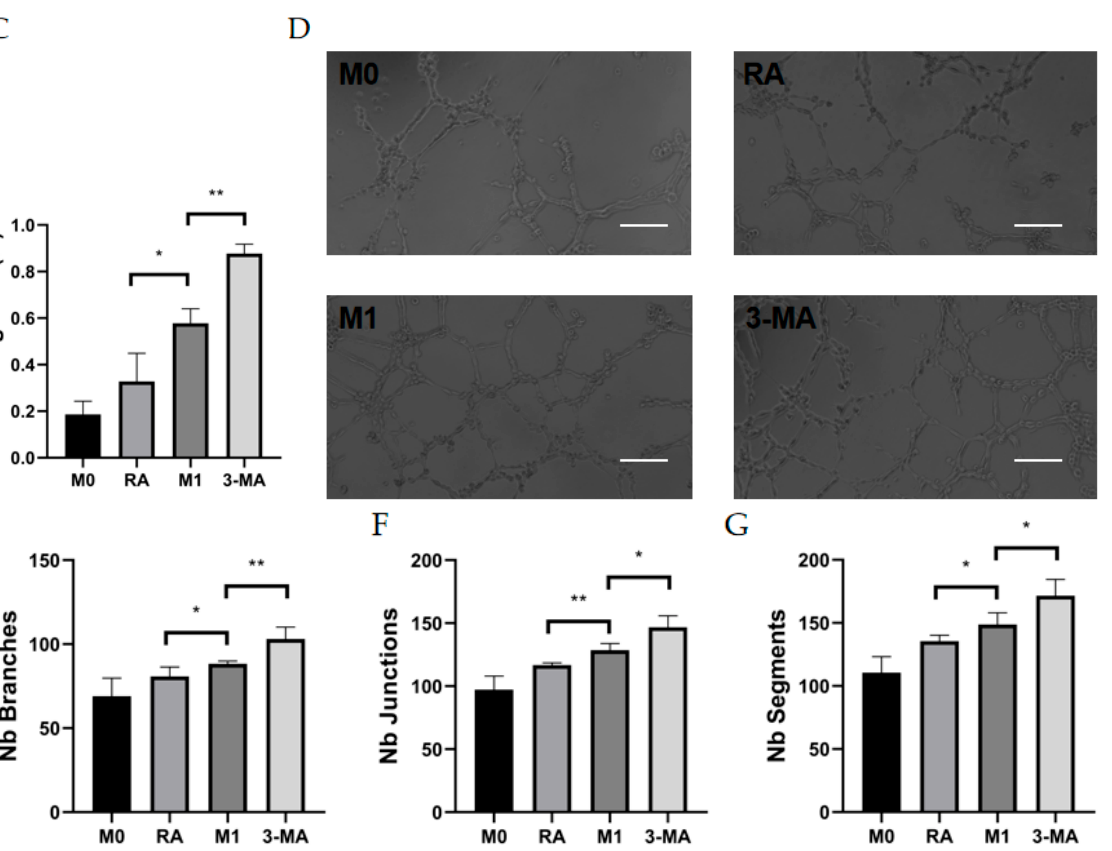
Figure 4. Vascularization ability of HUVECs after co-culture with culture supernatants of macrophages with different autophagy states. ( A ) The cell viability of HUVECs after co-culture with different culture supernatants (MOCM, RACM, M1CM, 3MCM) for 3 h to 6 h analyzed by CCK8 assay.